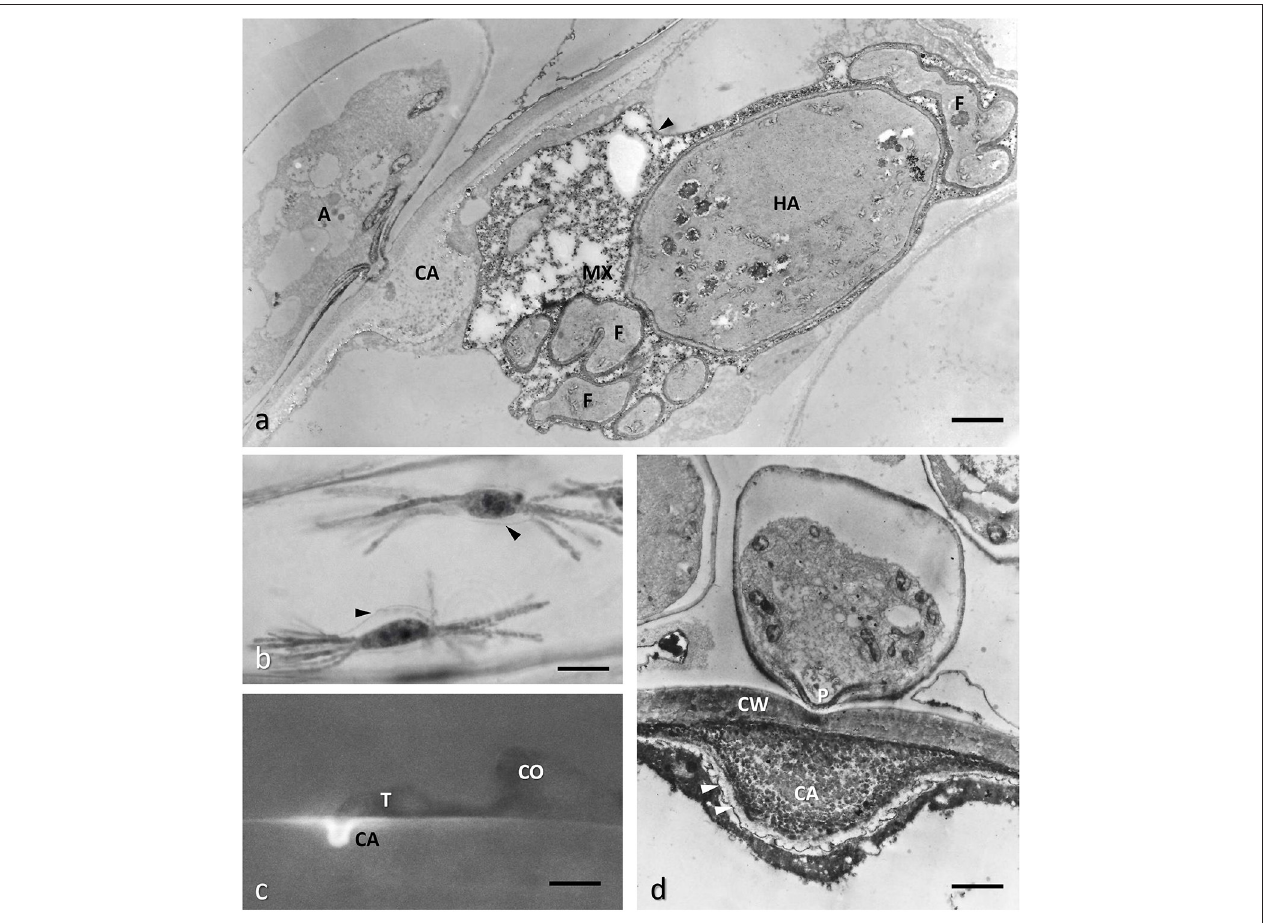
FIGURE 7 | Barley epidermal cell infected with Blumeria graminis f.sp. hordei showing different phases of the infection process. (a) TEM image of a conventionally fixed haustorium (HA), fully developed with numerous finger-like protrusions (F); the host membrane surrounding HA, also called extra-haustorial membrane, appears thickened (arrowheads); the extra-haustorial matrix (MX) contains granular and amorphous materials; the haustorial neck is out of the section plane, however a large callose collar (CA) is visible at the penetration site; the protoplasm of the appressorium (A) is moving to the HA. Bar, 1.6 µ m. (b) Interference-contrast light microscopy of two fully expanded haustoria in an epidermal cell showing finger-like protrusions and the thickened host plasma membrane surrounding them (arrowheads). Bar, 20 µ m. (c) Fluorescence microscopy of a penetration attempt stopped by the apposition of a callose papilla (CA, stained with aniline blue) by a resistant barley cultivar; the attempt is made by the germ tube (T) of the fungus from a germinated conidium (CO). Bar, 5 µ m. (d) TEM image of the callose papilla: note that it is formed as soon as the penetration peg (P) starts to perforate the host cell wall (CW); the papilla is filled also with electron-dense material, possible polyphenols, which are also deposited along the host plasma membrane (arrowheads); courtesy of D. Maffi. Bar, 0.14 µ